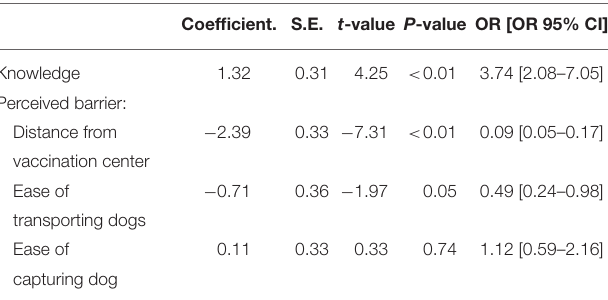
TABLE 3 | Model predictors for dog owners’ intention to vaccinate their dogs, showing coefficients, significance values, and odds ratios with 95% CI. Coefficient. S.E. t -value P -value OR [OR 95%